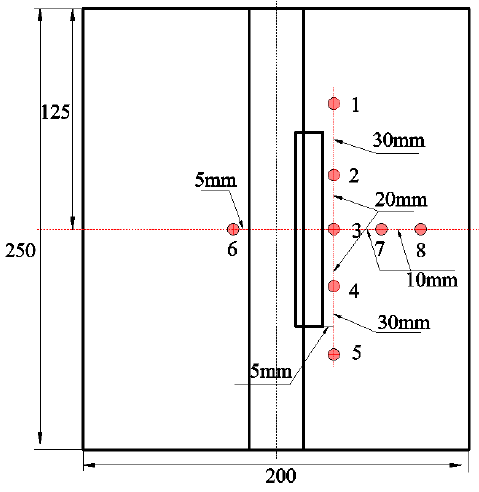
Figure 6. Test points after the HESD welding.